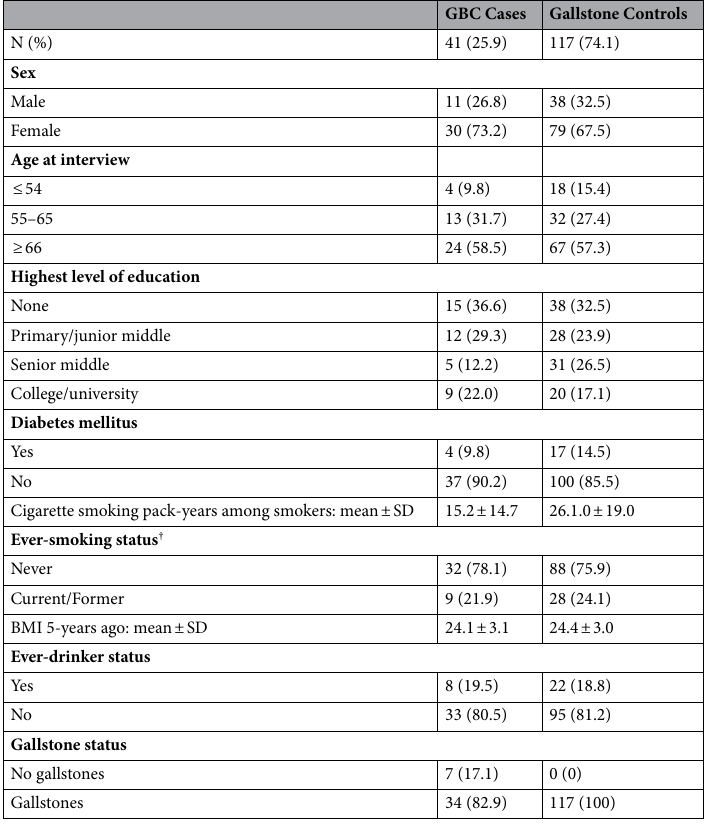
Table 1. Participant characteristics by GBC case and gallstone control status. † N < 117 for the gallstone controls, because of missing